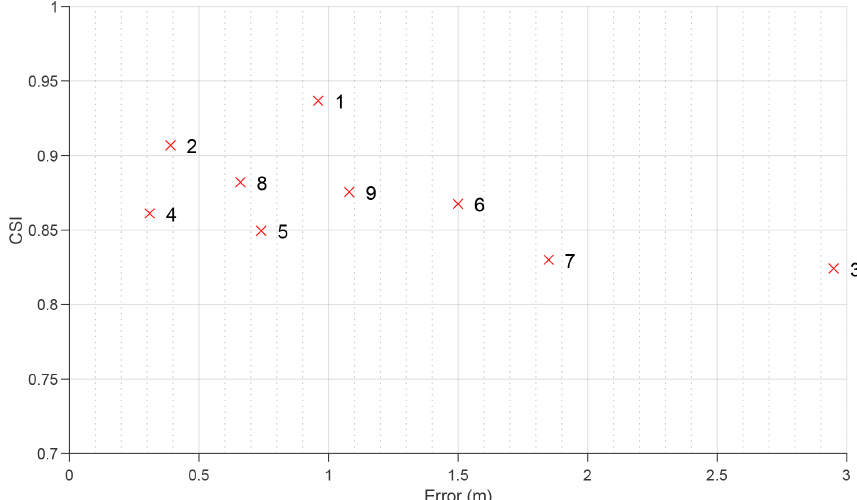
Figure 5. The relationship between the WSE error and flood extent CSI for the nine events. Numbered crosses refer to the ID of the flood